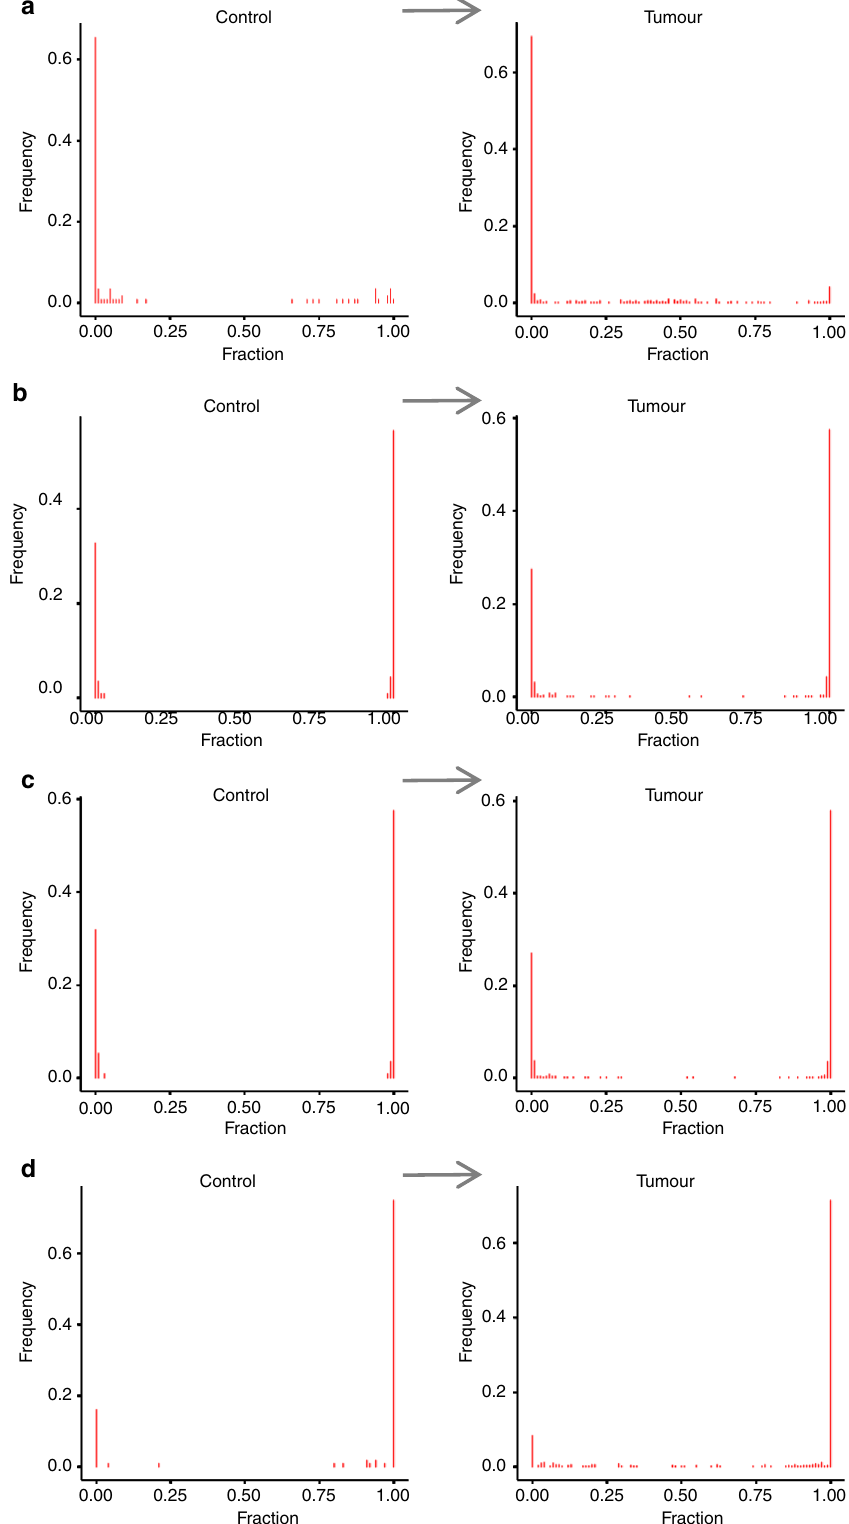
Fig. 2 SNP positions differentially imprinted between normal and cancer samples. a MEST (rs10863, adj. p -value = 0.022). b H19 (rs2839704, adj. p -value = 0.069). c H19 (rs2839703, adj. p -value = 0.082). d HM13 (rs6059873, adj. p -value =